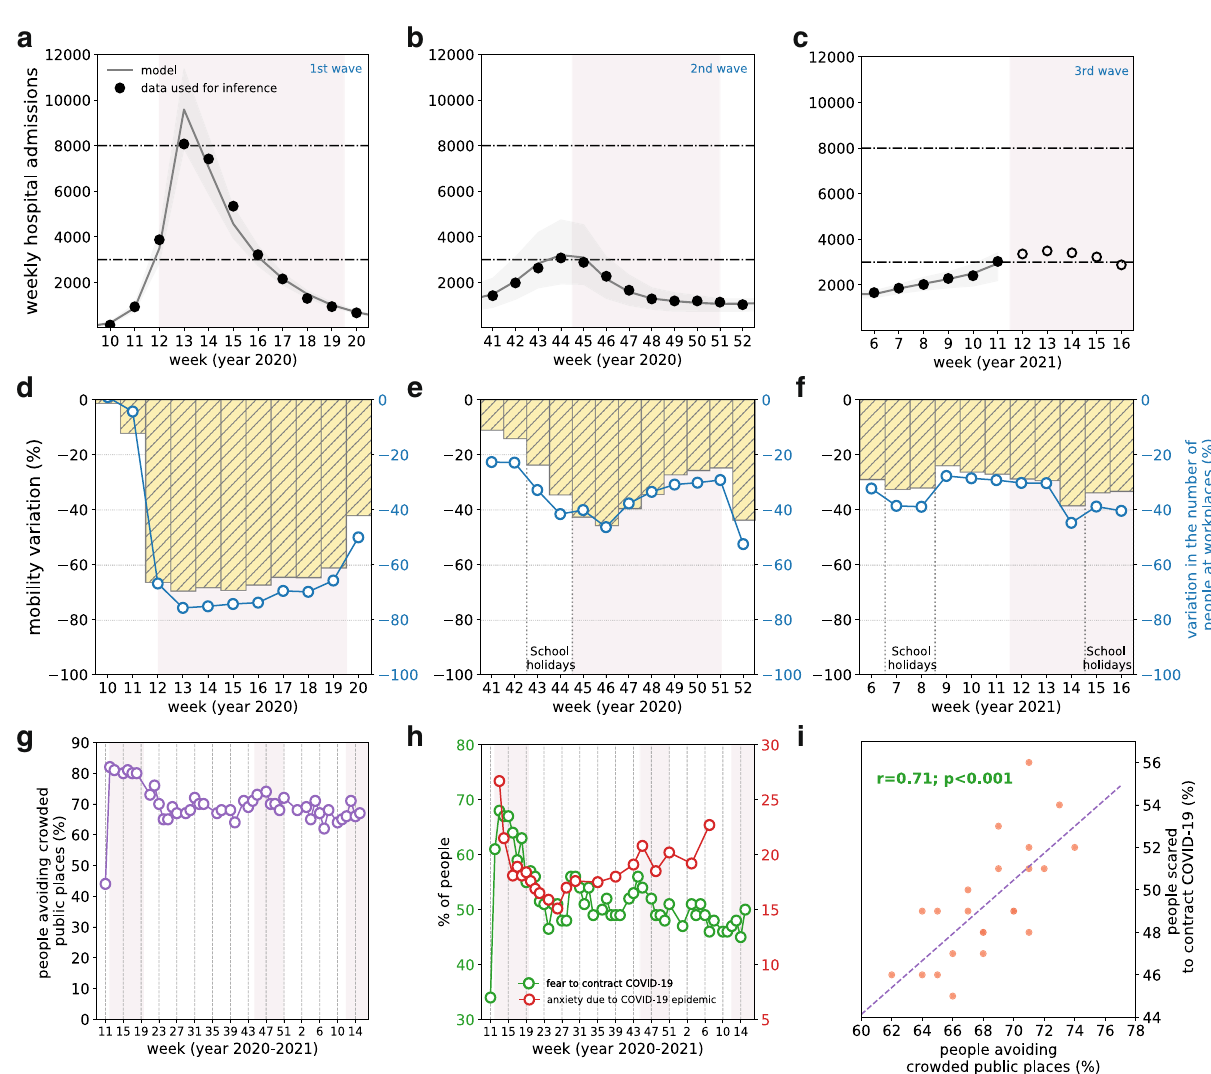
Fig. 1 COVID-19 pandemic waves in Île-de-France, with associated mobility reductions, social distancing, risk perception, and psychosocial burden. a – c Weekly hospital admissions in Île-de-France during the fi rst ( a ; weeks 10 – 20, March 2 – May 17, 2020), second ( b ; weeks 41 – 52, October 5 – December 27, 2020), and third ( c ; weeks 6 – 16, February 8 – April 25, 2021) pandemic wave. Dots refer to data; fi lled dots correspond to the data used to fi t the model, void dots correspond to data outside the inference window. Curves and shaded areas correspond to median fi tted trajectories and 95% probability ranges, obtained from n = 250 independent stochastic runs. Horizontal dashed lines refer to the peak of the fi rst and second wave in the region. d – f Mobility reduction in Île-de-France during the fi rst ( d ), second ( e ), and third ( f ) pandemic wave. Yellow histograms represent the variation of mobility with respect to prepandemic levels, based on the number of trips extracted from mobile phone data 12 . Blue curves show the estimated change in presence at workplace locations over time with respect to prepandemic levels based on Google location-history data 15 . Shaded rectangles in the plots of the fi rst two rows correspond to social distancing measures (strict lockdown in the fi rst wave, moderate lockdown in the second wave, strengthened measures in the third wave). The second week of the second lockdown and the third week of the strengthened measures against the third wave have lower mobility and presence at workplaces due to bank holidays in the week. Vertical dotted gray lines correspond to school holiday periods. g – i Percentage of individuals avoiding crowded public places 16 ( g ), percentage of individuals scared to contract COVID-19 16 and prevalence of anxiety in the context of COVID-19 epidemic ( h ) 17 as functions of time; scattered plot between the percentage of individuals scared to contract COVID-19 and the percentage of individuals avoiding crowded places ( i ) in the time period October 2020 – April 2021 (full time period shown in Supplementary Fig. S5), with the results of a Pearson correlation test (effect size 0.71, p -value < 10 − 3 ). Results for these indicators refer to the national scale. Shaded rectangles in panels g , h correspond to social distancing measures as in panels a – f